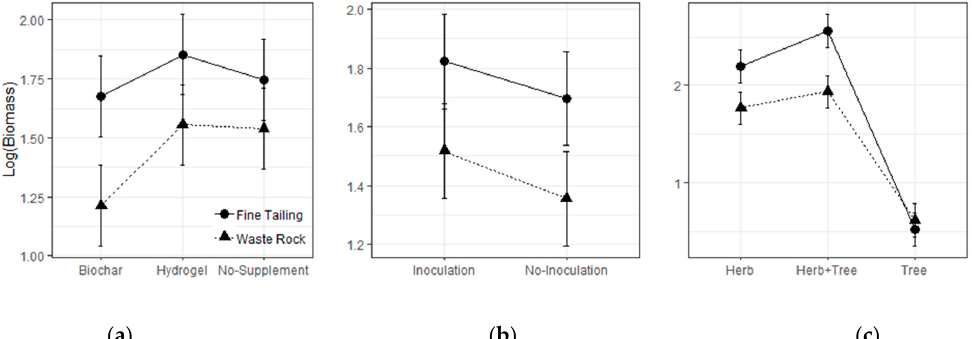
Figure 5. ( a ) The interaction e ff ect of substrates materials and soil amendment on total biomass. ( b ) The interaction e ff ect of substrates materials and microbial inoculation on total biomass. ( c ) The interaction e ff ect of substrates materials and plantation method on total biomass. The error bars represent the 95% con fi dence interval (CI) of means.